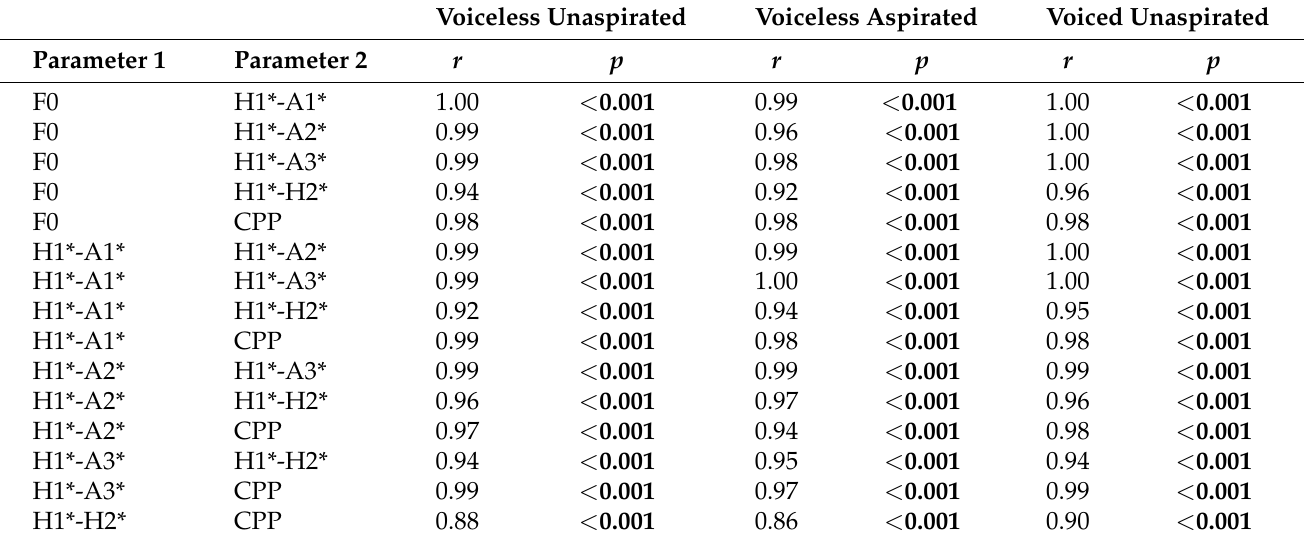
Table 3. Correlations among F0, H1*-H2*, H1*-A1*, H1*-A2*, H1*-A3*, and CPP. Voiceless Unaspirated Voiceless Aspirated Voiced